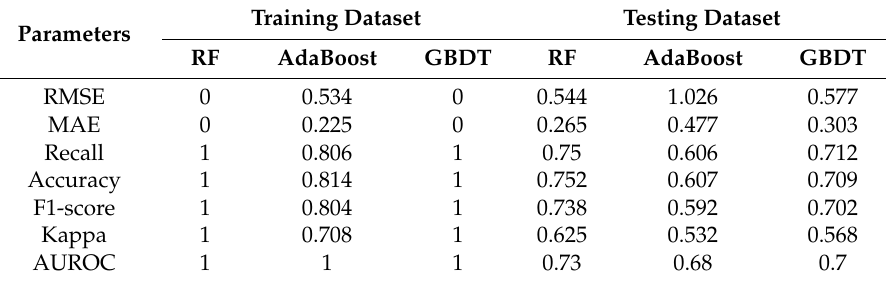
Table 3. Model performance for the training and testing datasets.